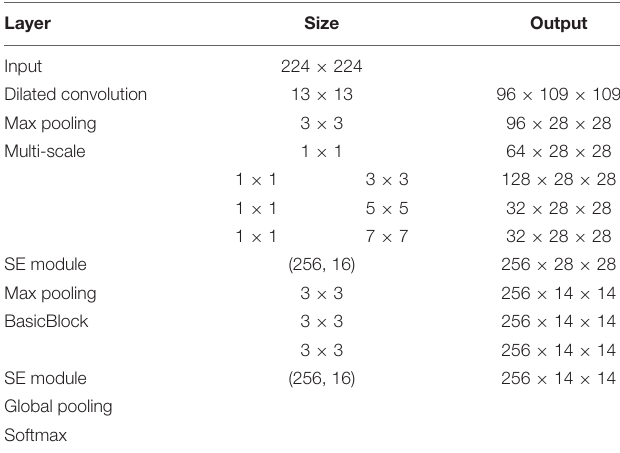
TABLE 2 | Table of module parameters in our model.